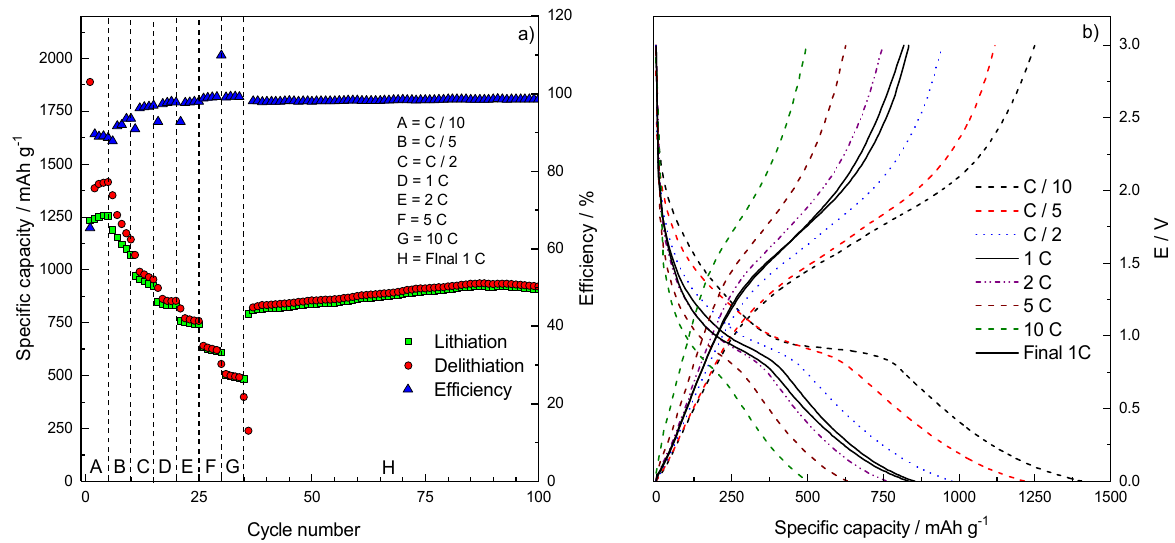
Figure 7. ( a ) Rate capability of Fe 3 O 4 /rGO performed in the potential window within 0.001 < E < 3.000 V vs. Li + /Li. ( b ) Galvanostatic E vs. Q profiles of third cycle at each rate. Table 1. Specific capacities and efficiencies of the Fe 3 O 4 /rGO at different C-rates, as from Figure